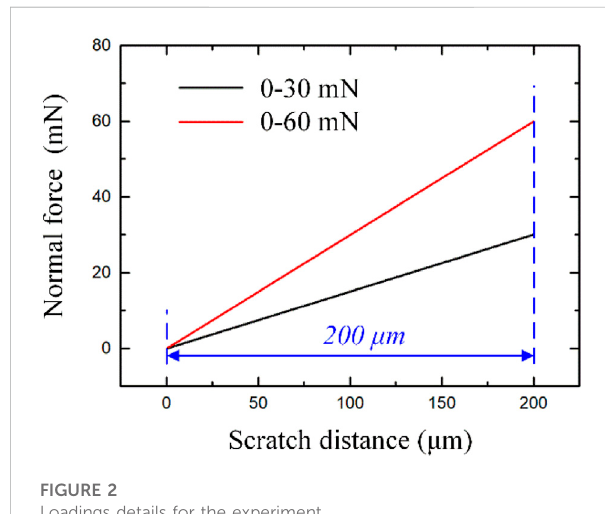
Figure 5A. In the second stage, the penetration depth of the indenter